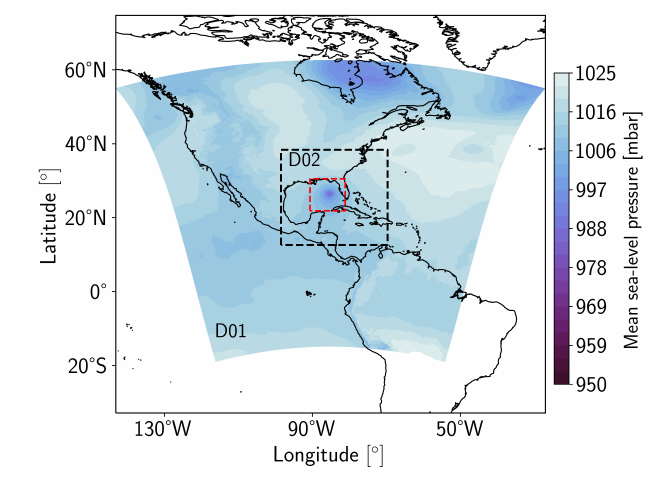
Figure 1. Spatial domains of the HWRF atmospheric model. The area covered by the pressure field indicates the extent of the fixed domain (D01), the black segmented line indicates the area covered by the second mobile domain (D02) and the red segmented line indicates the third mobile domain (D03). In this work, HWRF is set up to use the physical parameterizations indicated in Table 2.